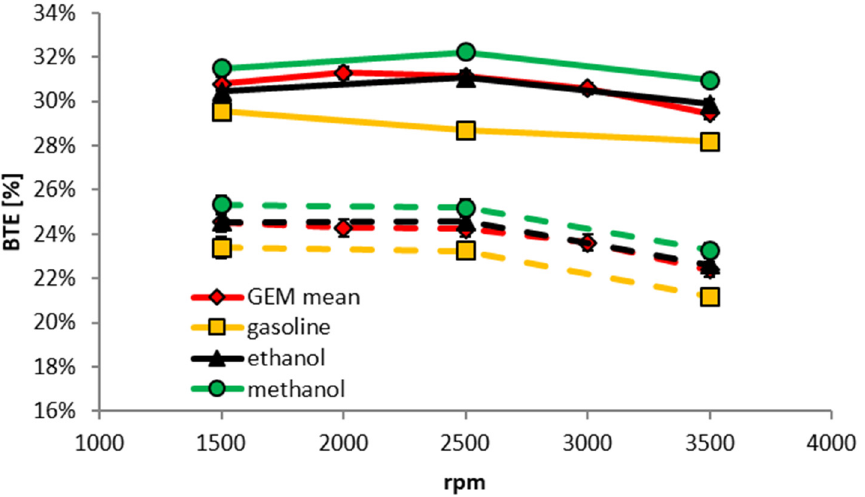
Figure 13. Brake thermal efficiency when operating on various fuels as a function of engine speed for different fixed brake torques of 40 Nm (2.82 bar BMEP) (dashed lines) and 80 Nm (5.64 bar BMEP) (solid lines).